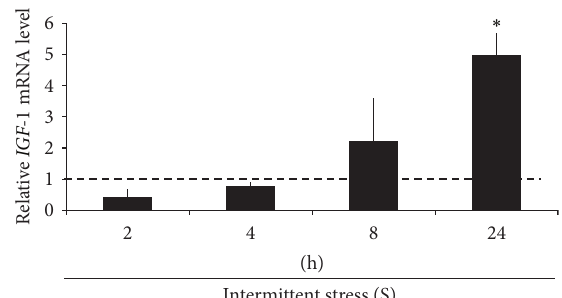
Figure 1: Intermittent mechanical stress-induced IGF-1 expression. HPDLs were treated with intermittent mechanical stress for 2 h, 4 h, 8 h, and 24 h. The IGF-1 mRNA expression was determined using real-time PCR. The dot line represented the expression levels of the control. Asterisks indicated statistically significant